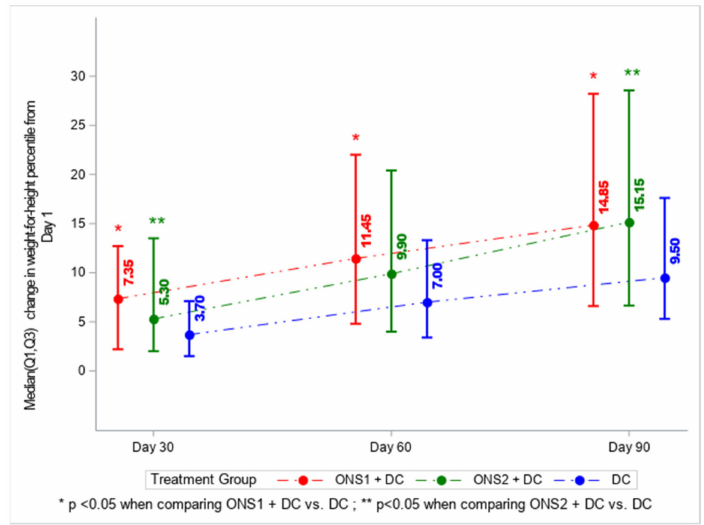
Figure 2. Change in weight-for-height percentile from Day 1 to Days 30, 60, 90 by intervention group: ONS1 + DC, ONS2 + DC, or DC only. p -values were calculated using the Wilcoxon rank sum